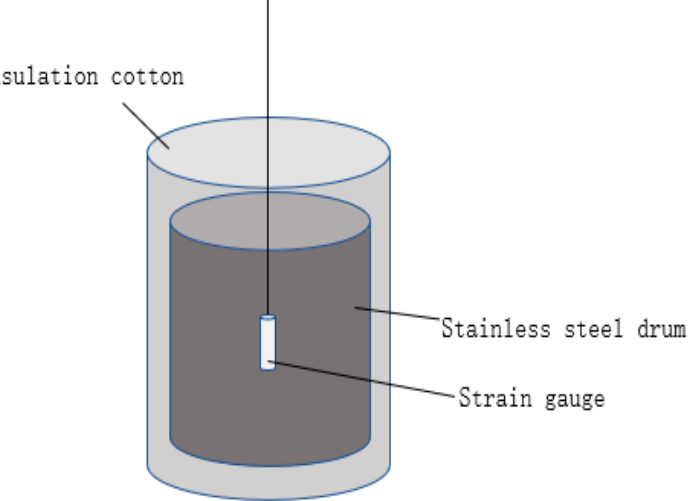
Figure 2. Schematic diagram of the simulation tool.